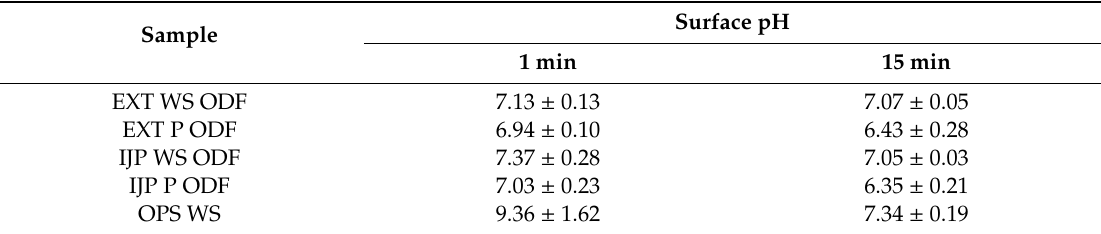
Table 5. Surface pH of the drug-loaded 2 mg and corresponding placebo dosage forms after 1 min